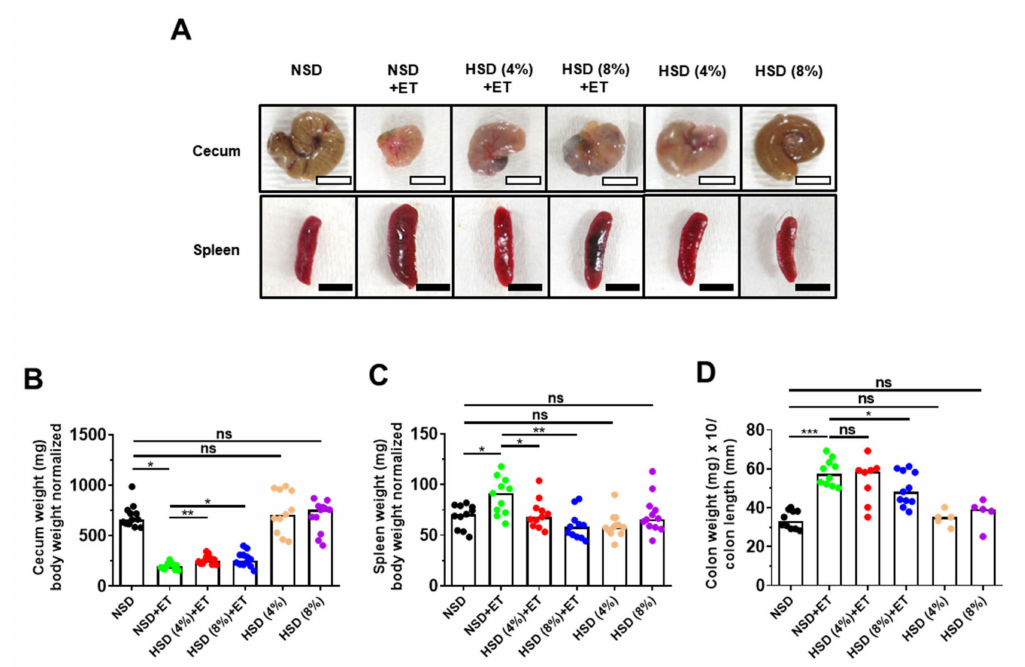
Figure 2. HSD decreases clinicopathologic indicators of cecum weight, spleen weight and colon weight per colon length in ETBF-infected mice. C57BL / 6 female mice were inoculated with WT-ETBF (~1 × 10 9 CFU). HSD (4% and 8%) treated groups were given chow containing either 4% NaCl or 8% NaCl, respectively. C57BL / 6 mice were sacrificed at day 18 post-infection. ( A ) Representative images of cecum and spleen. ( B ) Cecum weight (mg) / body weight (g). ( C ) Spleen weight (mg) / body weight (g). ( D ) Colon weight (mg) / colon length (mm). Colon weight (mg) / colon length (mm) ratios were measured at day 7 post-infection. NSD, normal salt diet; HSD, high salt diet; ET, ETBF. Each dot represents one mouse ( n = 5–12 mice per group) in the scatter plots. Horizontal bar represents the median. * p < 0.05; ** p < 0.01; *** p < 0.001; ns, no statistical